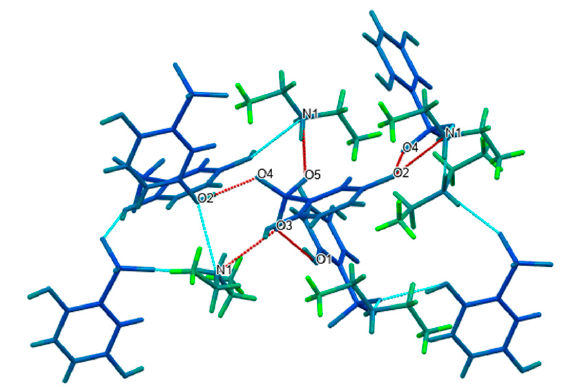
Figure 11. The 3D packing structure of the diethylammonium salt of DBS.